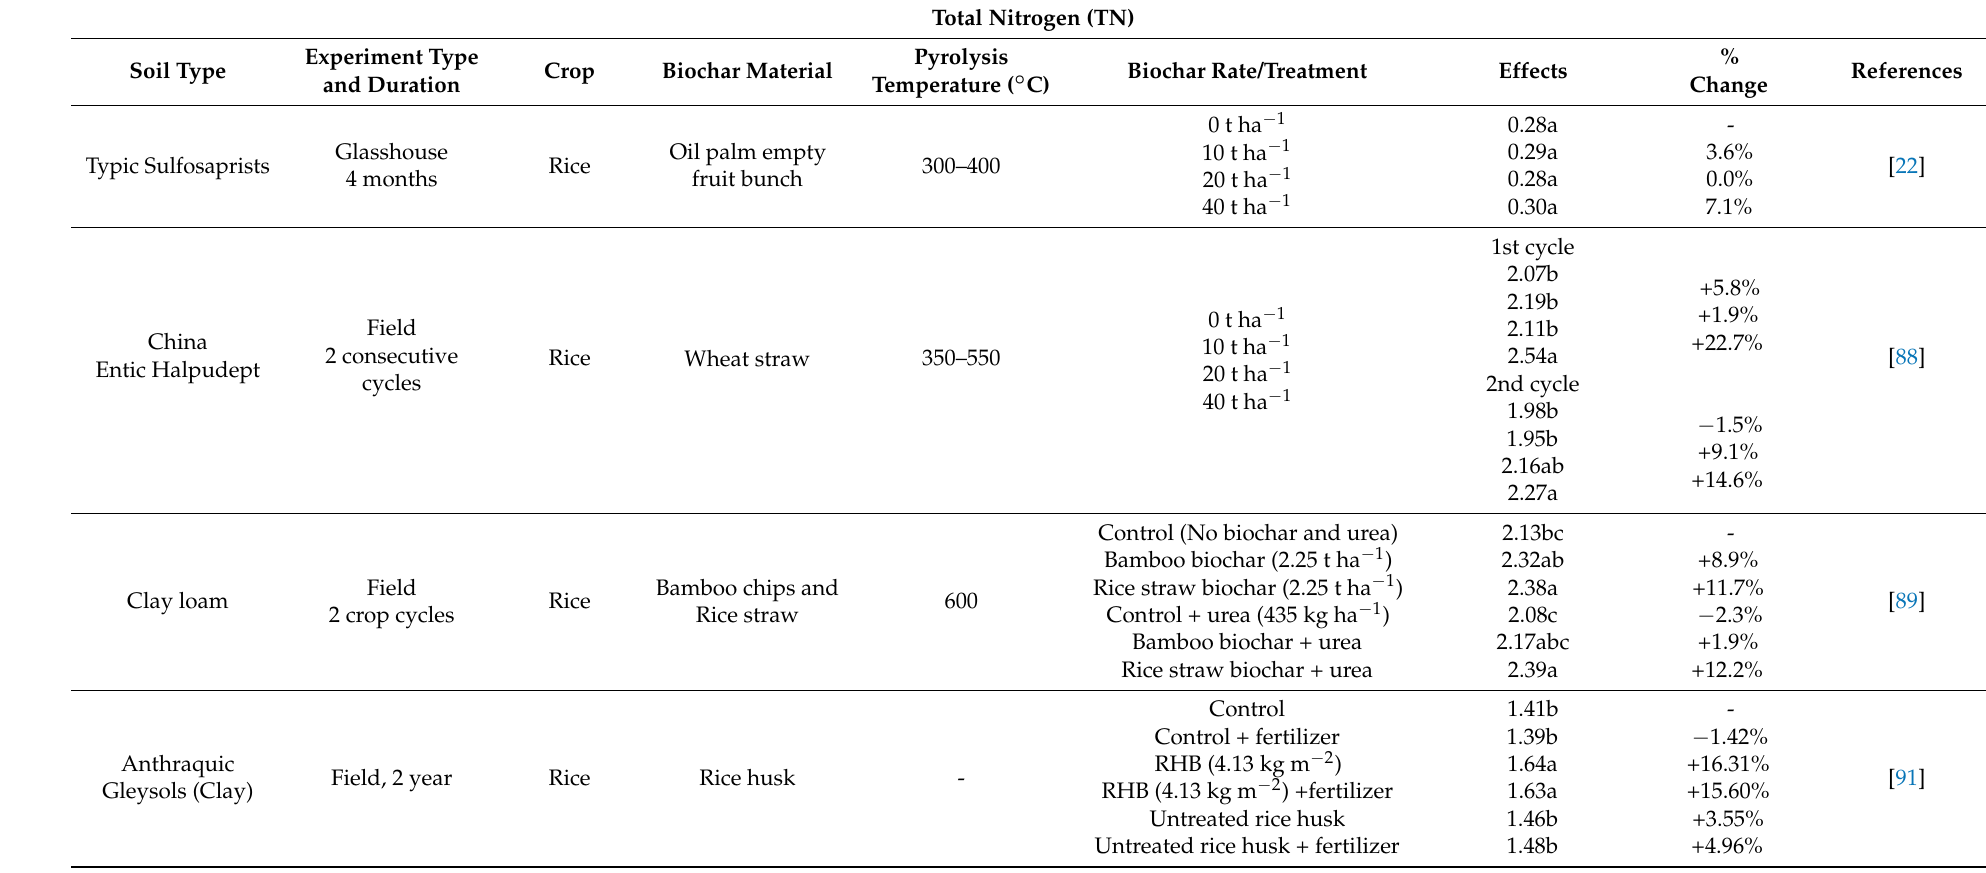
Table 3. Enrichment of soil nutrients (N, P, and, K) by biochar incorporation from previous studies (different letters in the same column indicating significant difference among the biochar